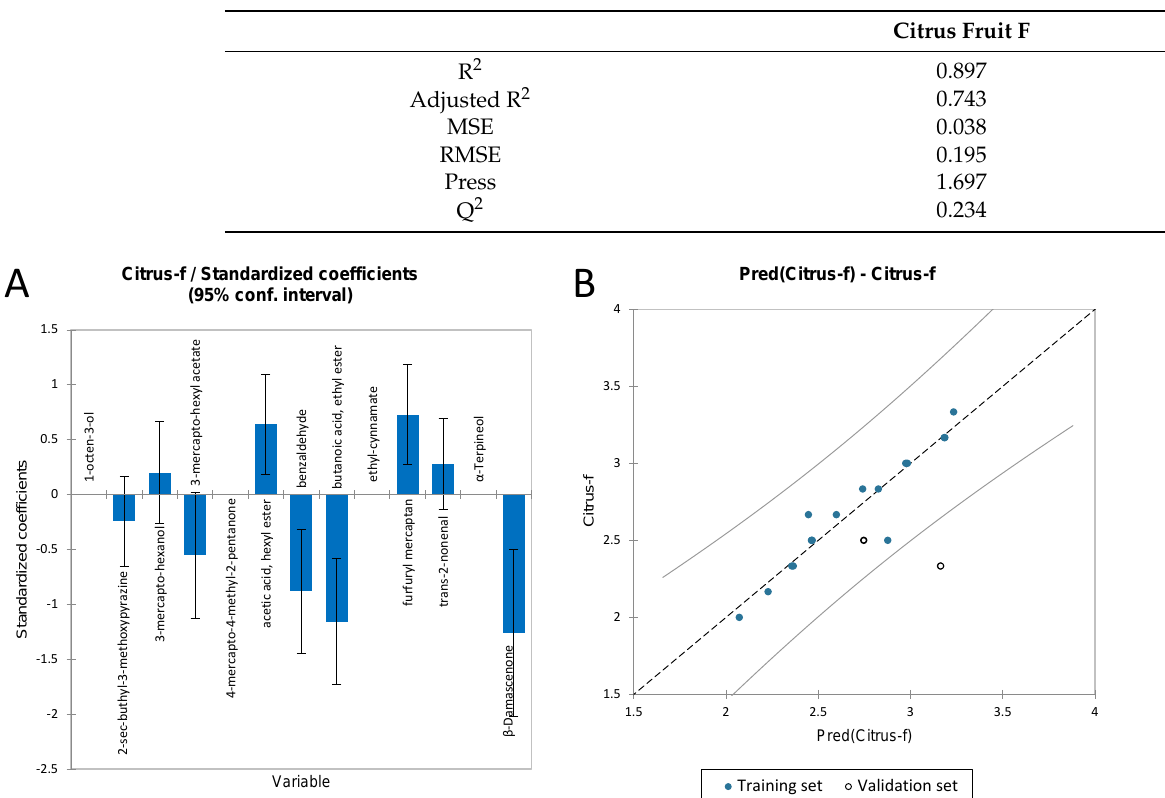
Figure 10. ( A ) Standardised coefficient effect in the multiple linear regression for citrus flavour on Sauvignon Blanc wines. ( B ) Predicted vs. experimental data graph for the multiple linear regression on Sauvignon Blanc wine’s citrus fruit flavour. The full regression model is reported in Supporting Information File S3—MLR SA